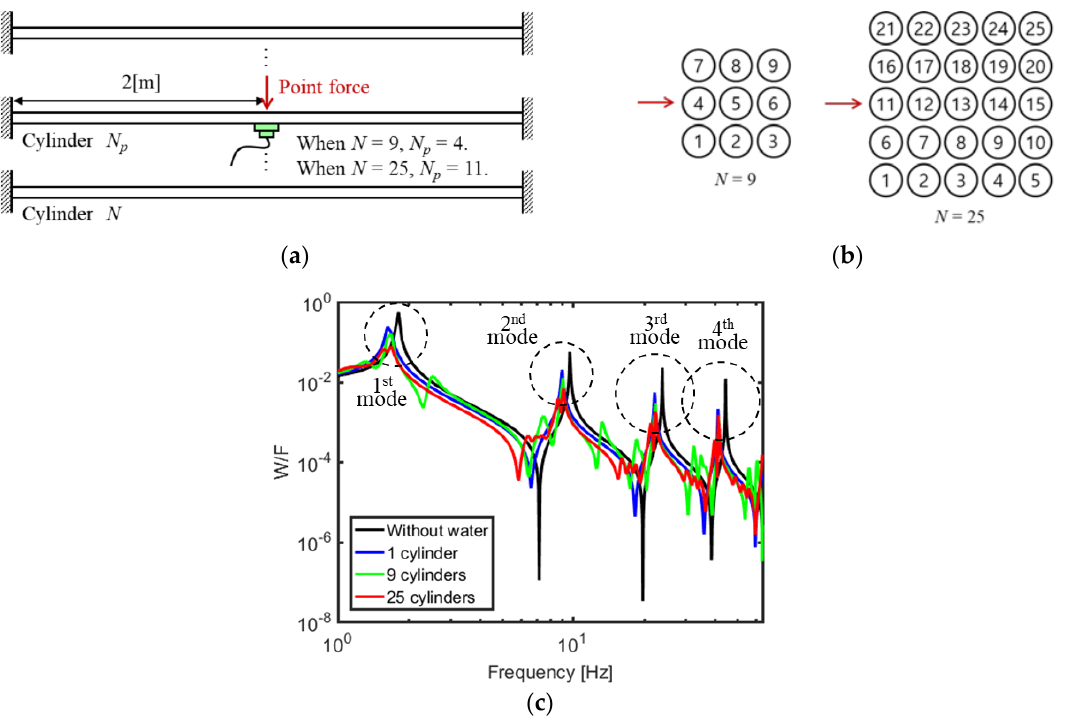
Figure 9. ( a ) Nuclear fuel rod bundles varying the number of cylinders in the fluid subjected to point force, ( b ) cross section, and ( c ) calculated transfer functions. force, ( b ) cross section, and ( c ) calculated transfer